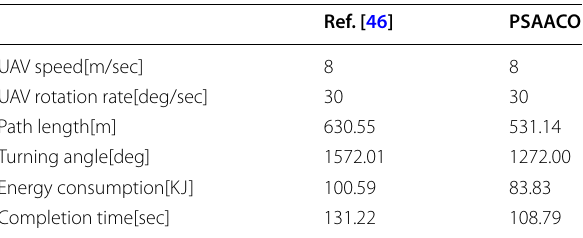
Table 10 Experiments on area 1 for performance comparison between PSAACO and algorithm in [46]